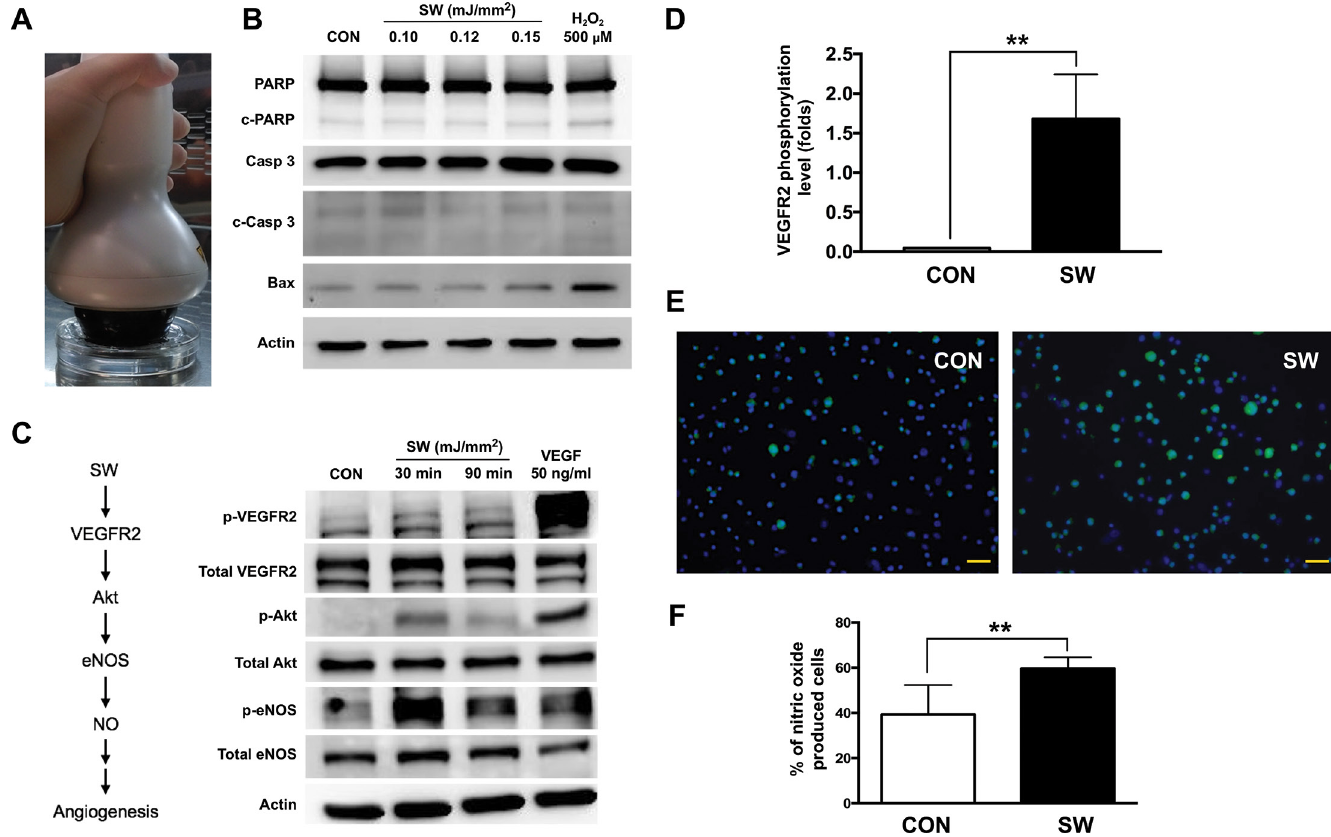
Figure 1. Activation of VEGFR2-Akt-eNOS signaling pathway by shock wave treatment in HUVECs. (A) Demonstration of shock wave delivery to culture dish. (B) Expressions of cellular apoptosis-related proteins in HUVECs 28 h post-SW treatment assessed by Western blot, including cleavage PARP (c-PARP), cleavage caspase 3 (c-Casp 3) and Bax. Treatment of H Illustration showed that SW-induced angiogenesis may be achieved through VEGFR2-Akt-eNOS signaling pathway. Phosphorylation of VEGFR2, Akt and eNOS in HUVECs at 30 min and 90 min post-SW treatment compared with those in the control (CON) without SW